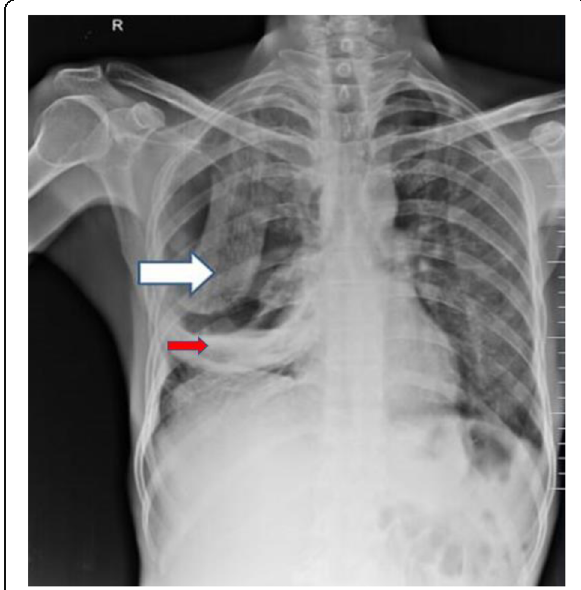
Fig. 1 Plain radiograph of chest posteroanterior view shows loculated right hydropneumothorax (red arrow) with collapsed lung (white arrow)